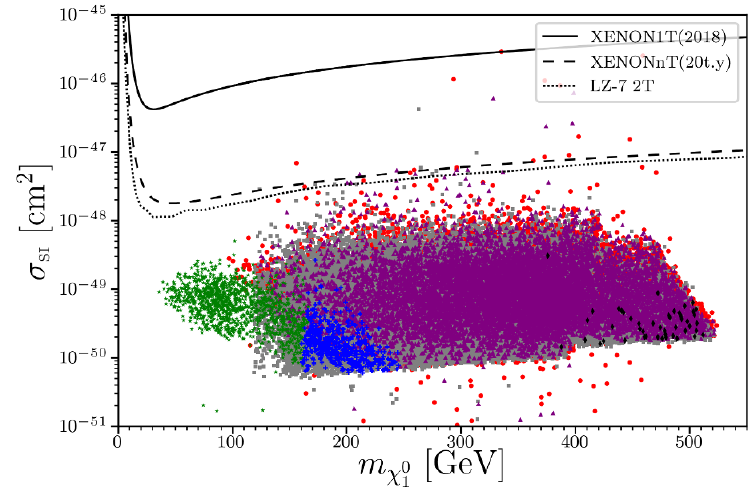
Figure 5 . Surviving samples with su(cid:14)cient dark matter relic density (0 : 107 < (cid:10) h 2 < 0 : 131) in the spin-independent DM-nucleon cross section (cid:27) SI (original values without being rescaled by (cid:10) = (cid:10) 0 ) versus LSP DM mass m . The limits of XENON1T in 2018, the future detection sensitivity of (cid:31) 0 1 XENONnT and LUX-ZEPLIN (LZ-7 2T) are shown by real, dashed and dotted curves respectively. Di(cid:11)erent annihilation scenarios of samples are also shown by di(cid:11)erent symbols with di(cid:11)erent colors: ~ (cid:28) 1 exchange by green star ‘ ? ’, ~ (cid:28) 1 hybrid3 by blue cross ‘+’, ~ (cid:28) 1 coannihilation by red bullet ‘ (cid:15) ’, (cid:31) (cid:6) coannihilation by purple triangle ‘ N ’, hybrid2 by gray square ‘ (cid:4) ’, and ~ ‘ annihilation by black lozenge ‘ (cid:7)